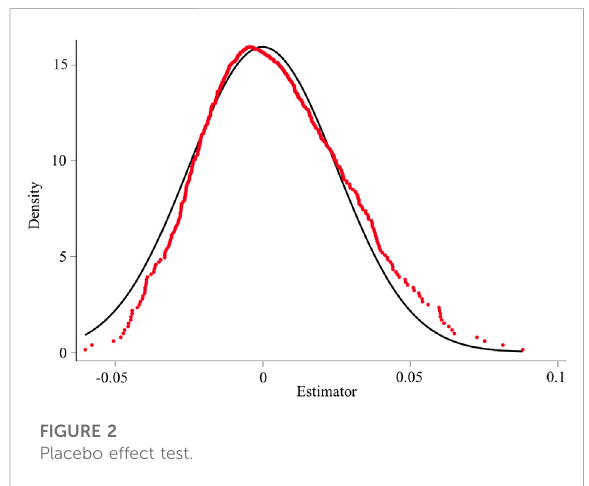
FIGURE 2 Placebo effect test.